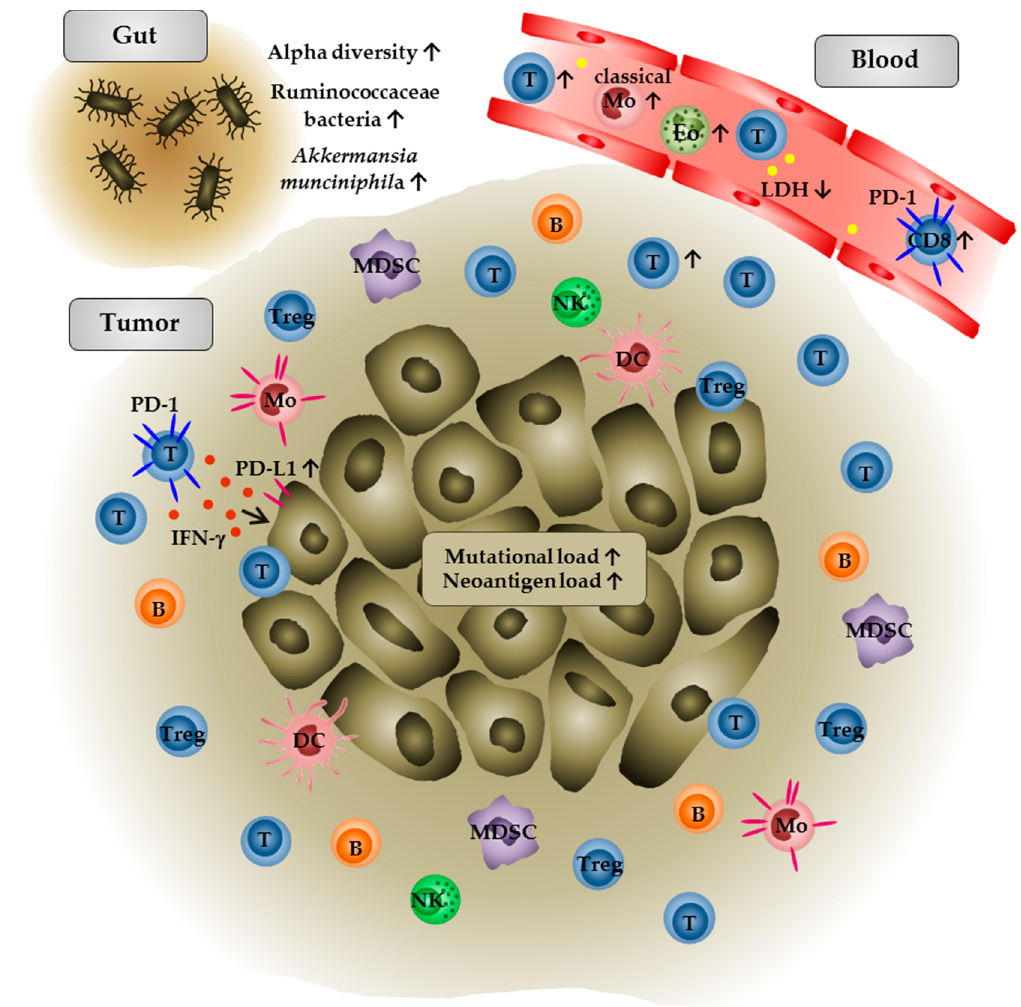
Figure 2. Immunological characteristics in anti-PD-1/PD-L1 antibody-treated tumor patients that are associated with clinical outcome. In peripheral blood, higher numbers of eosinophils, lymphocytes, PD-1 + CD8 T cells, and classical monocytes as well as low levels of LDH are associated with improved clinical responses. Within the tumor, higher densities of CD8 + T cells in pretreatment tumor samples and an increase in intratumoral CD8 + T cell frequencies during anti-PD-1 therapy are detectable in patients that show a clinical response. Further studies indicate that a high PD-L1 expression on tumor cells and infiltrating immune cells as well as a high intratumoral mutational and neoantigen load are correlated with an improved survival of patients. In addition, a significantly higher alpha diversity or a relative abundance of Ruminococcaceae bacteria and Akkermansia munciniphila in the gut microbiome are associated with favorable clinical outcome of tumor patients.